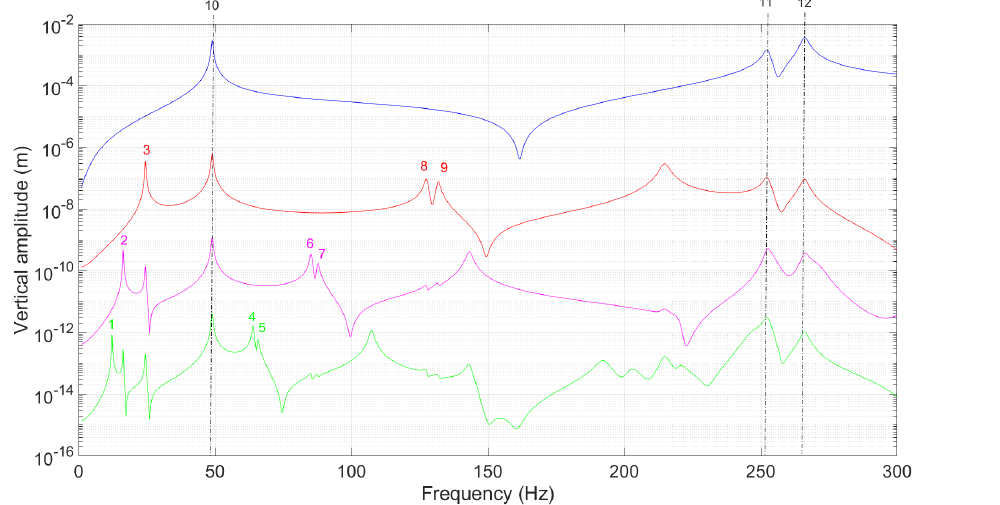
Figure 3. Vertical amplitudes at 0.1 m from the left side of the rotor system with a breathing crack (case 2— µ = 0.1 and L crack = 0.2625 m from the left side) (blue = nonlinear response, black = order 1, red = order 2, magenta = order 3, green = order